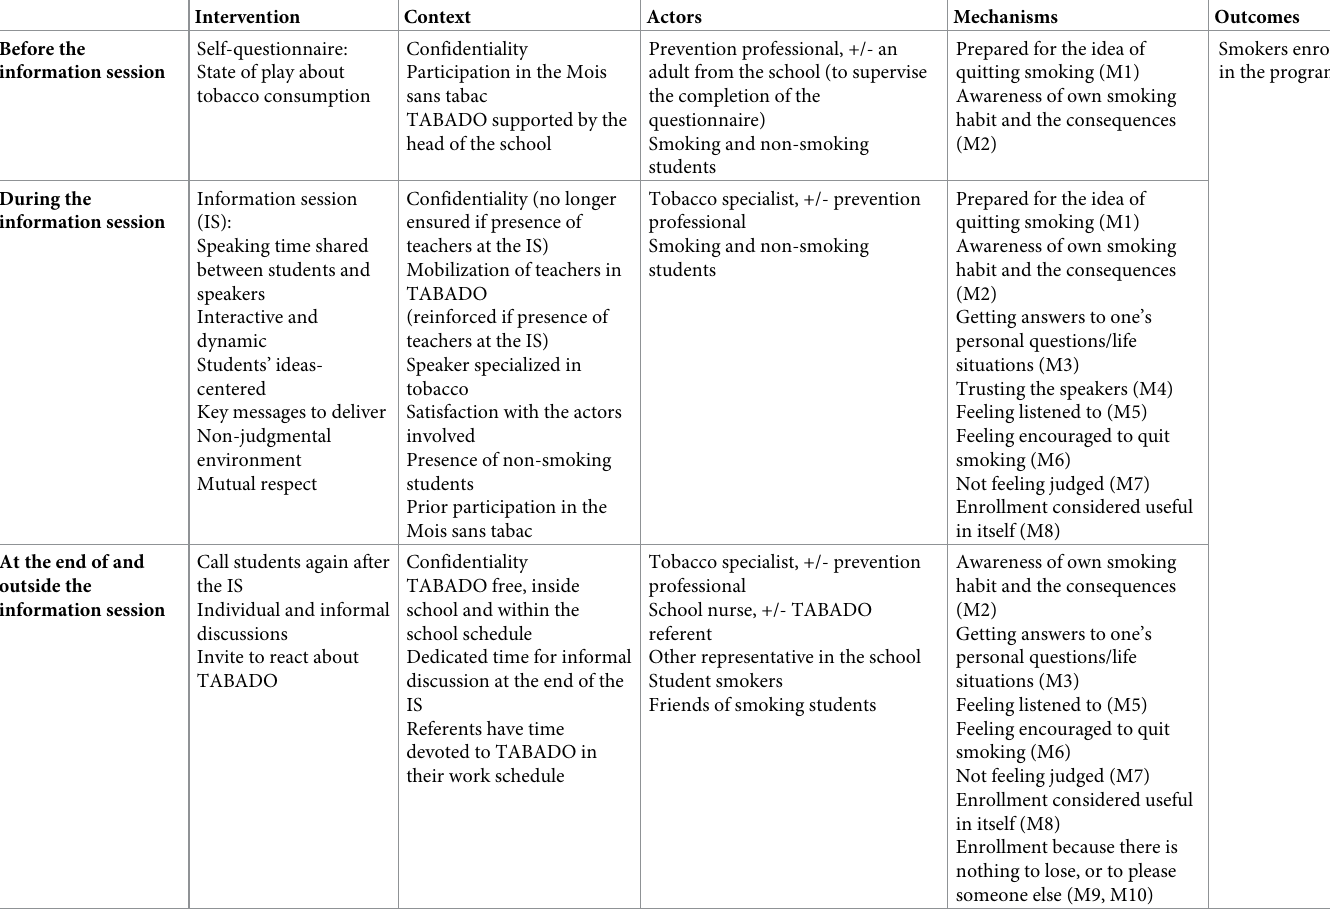
Table 3. ICAMO configurations for the enrollment in the program, before, during and at the end of the information session. Intervention Context Actors Mechanisms Outcomes Before the information